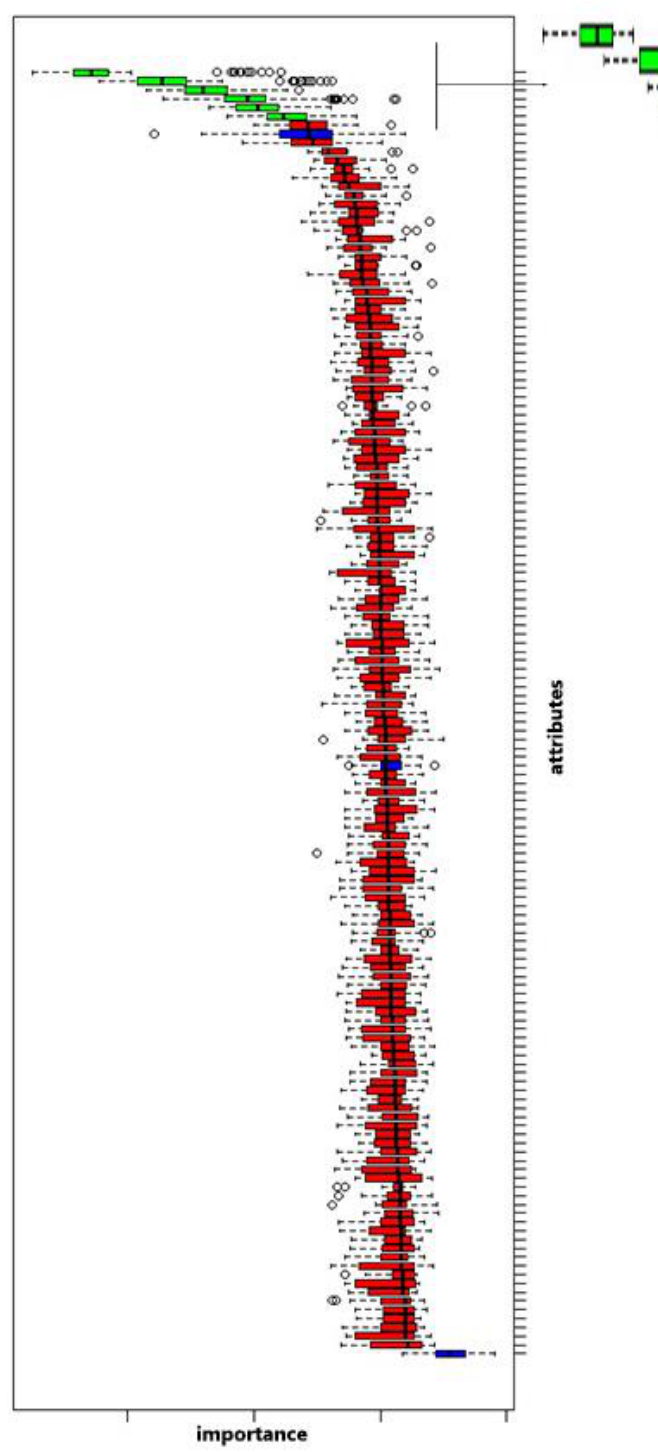
Figure 1. Box plot of Boruta decisional algorithm and detail of the green box plot with nomenclature of the main predictive fatty acids (FAs). Green box plot represented the fatty acid with the greatest predictive function. Red box plot represented the FAs with null predictive function.